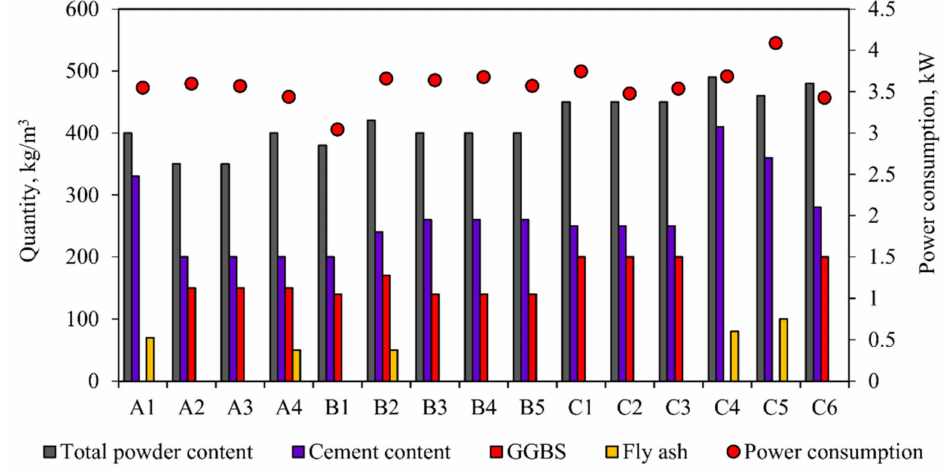
Figure 11. Power consumption versus total powder content (GGBS + fly ash + cement), GGBS, cement content, and fly